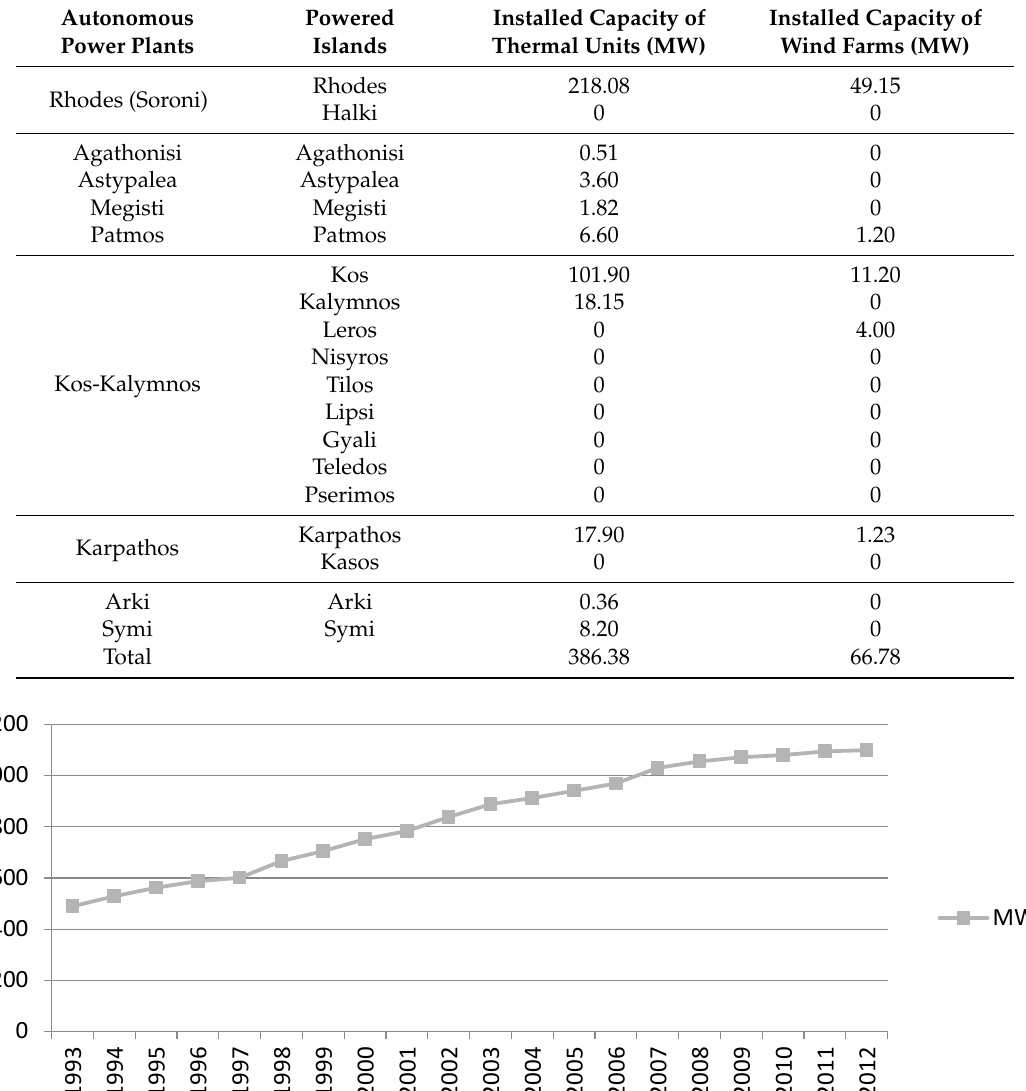
Figure 4. Annual energy consumption of the Dodecanese [52].